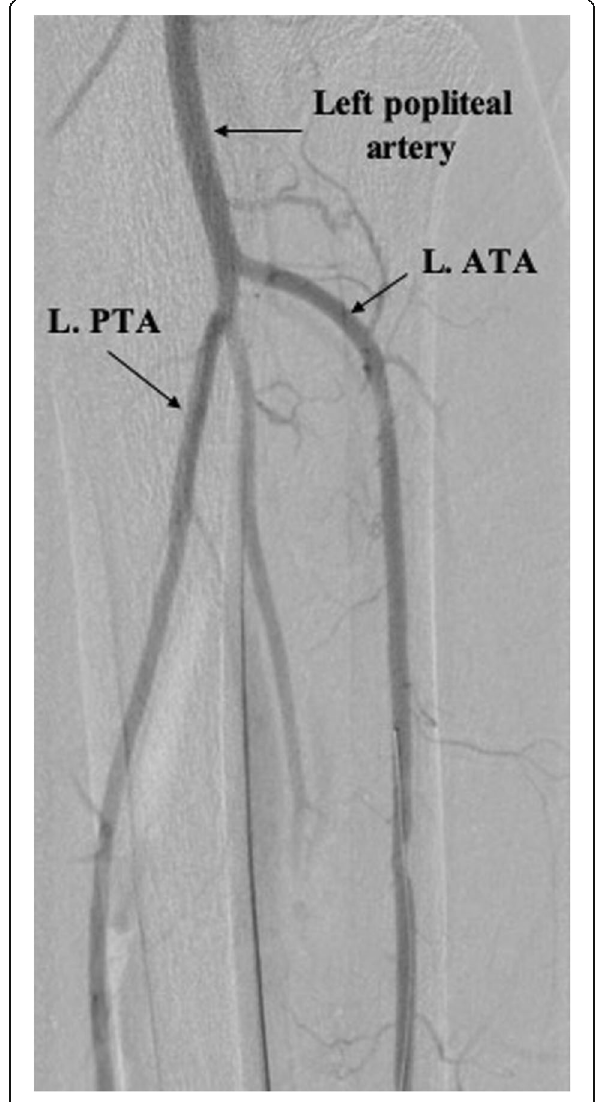
Fig. 1 A tibial artery angiogram showing patency of the distal left popliteal artery, left anterior tibial artery (L. ATA), and the left posterior tibial artery (L.